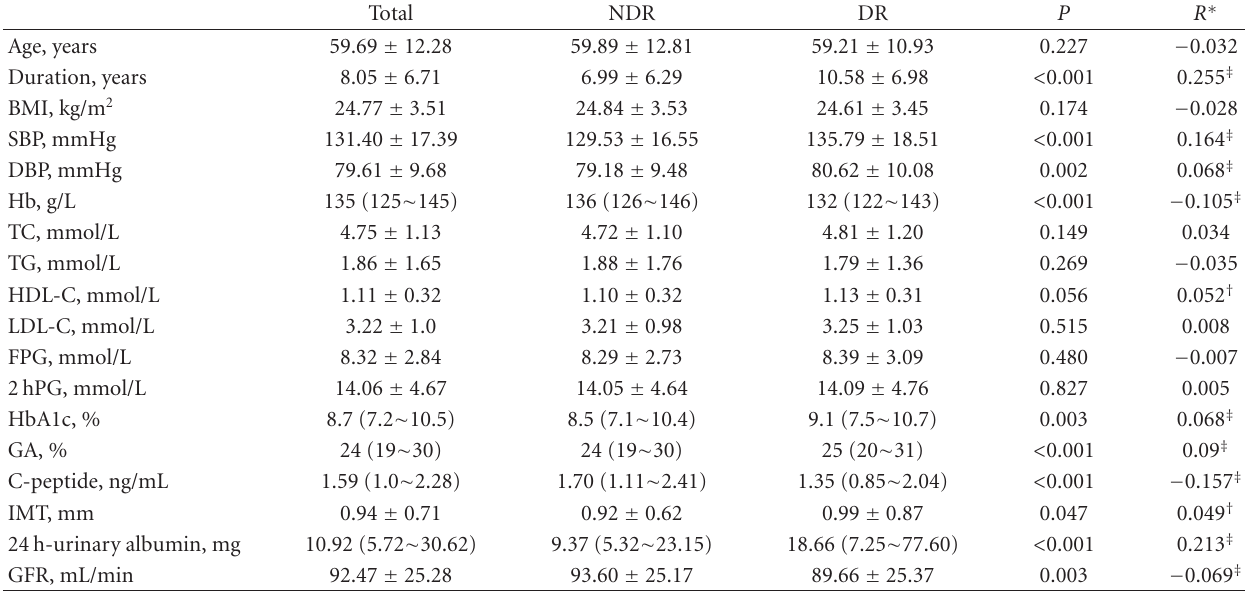
Table 2: Comparison of clinical parameters between DR groups.